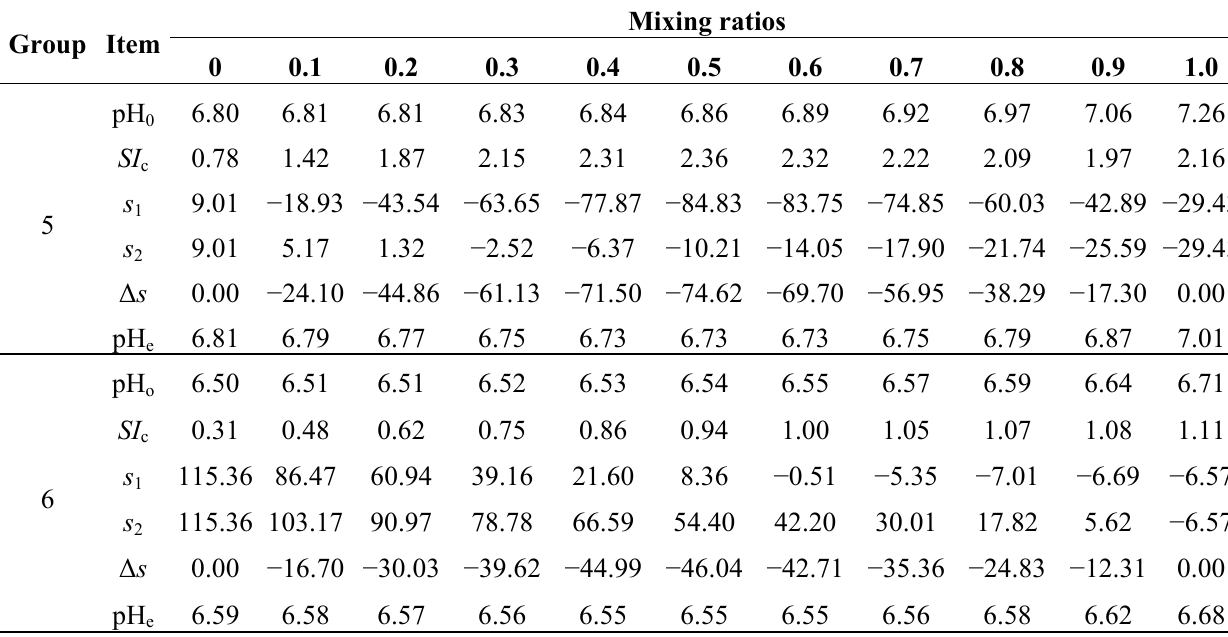
Table 5. Calculated results for mixed water from an unsaturated sample and